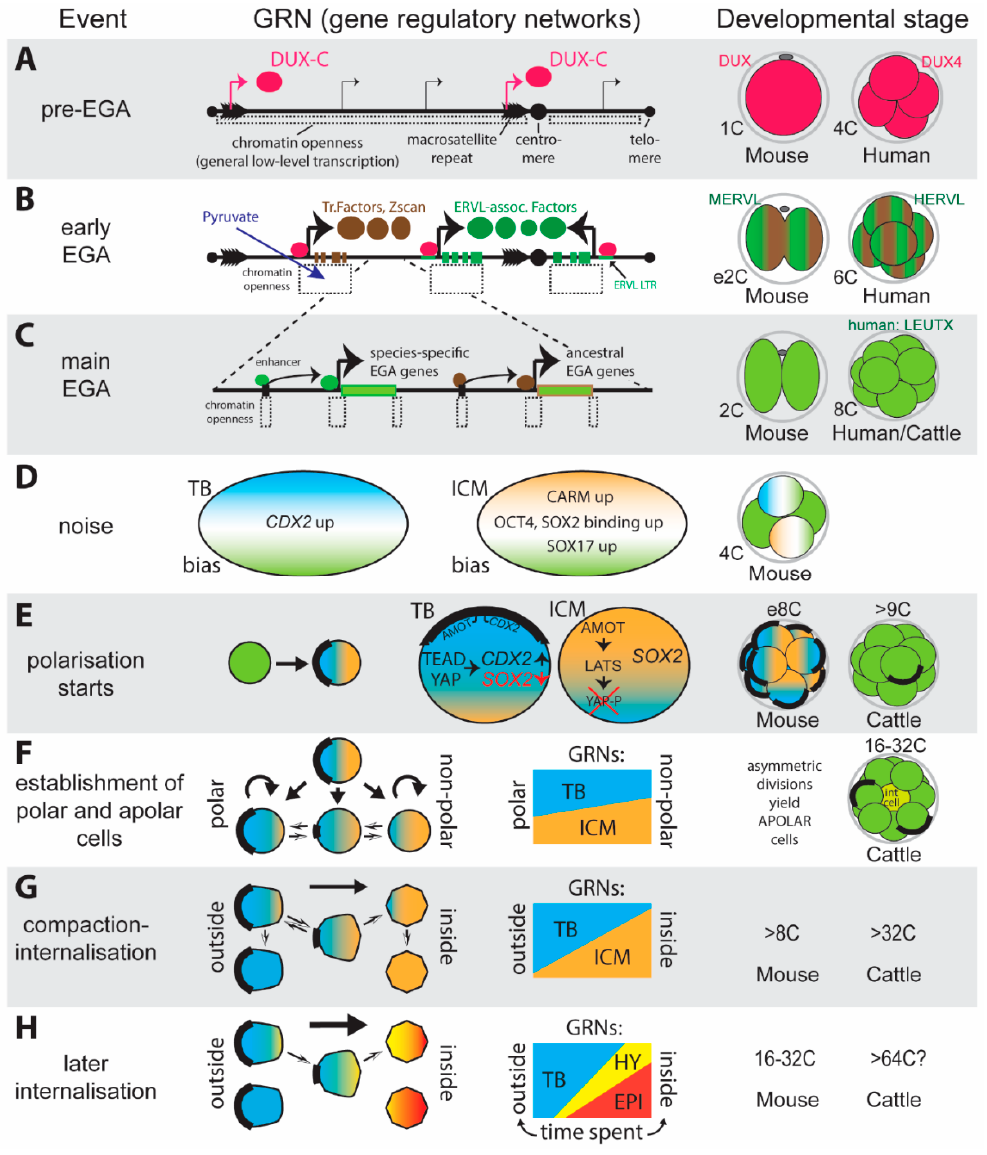
Figure 3. A summary of pre-blastocyst mammalian development with a focus on gene expression. ( A ) Post-fertilisation but prior to embryonic gene activation (EGA) a loosening of chromatin leads